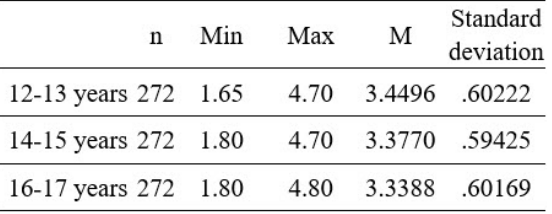
Table 3. Control of anxiety in relation